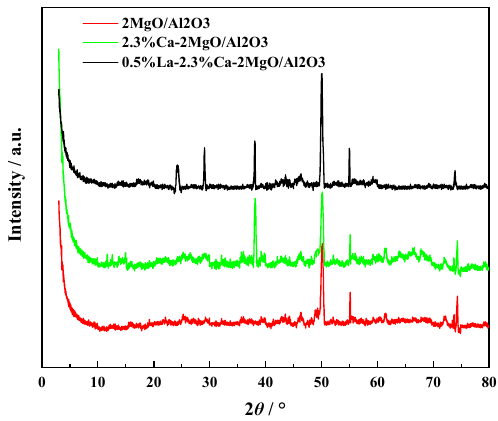
Figure 2. XRD patterns of composite oxides.